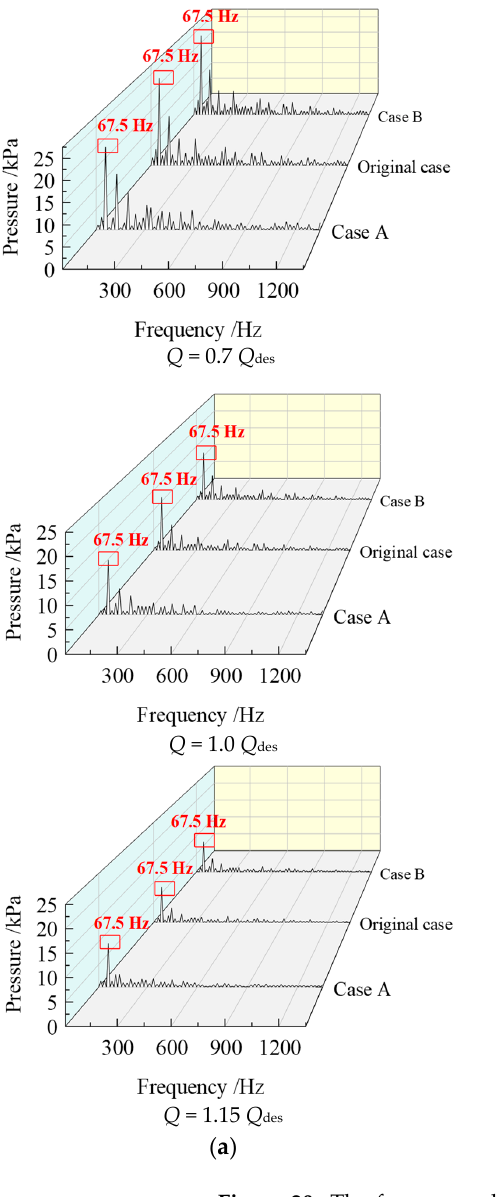
Figure 19. The time domain of pressure signal on B1 of three cases under ( a ) forward and ( b ) reverse conditions.